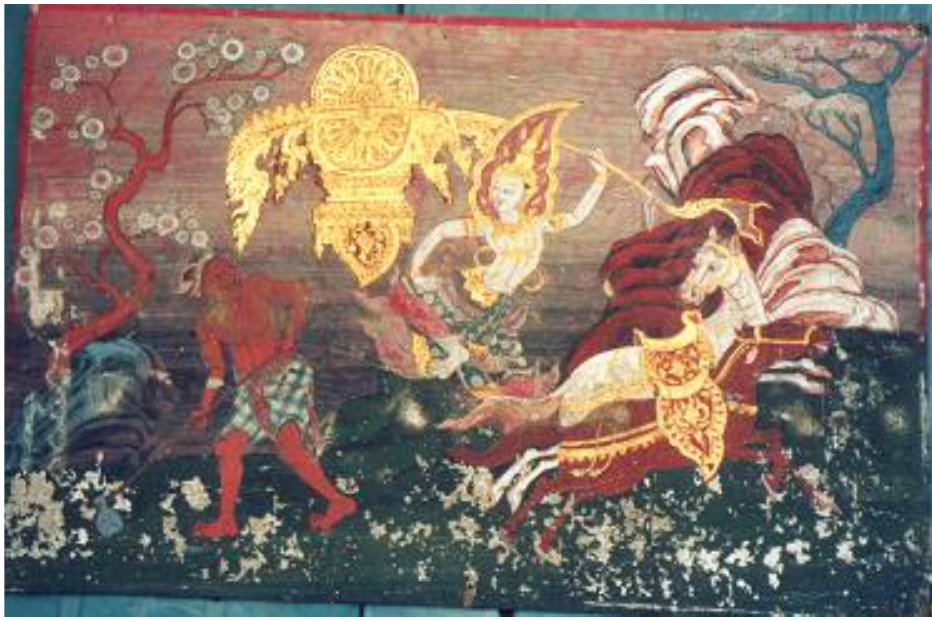
Figure 6. Temiya Jātaka, Thai, mid 20th century, Walters Museum mid 20th century (Rattanakosin) . Figure 6. Temiya J¯ataka, Thai, mid 20th century, Walters Museum mid 20th century (Rattanakosin). MEDIUM; pigments on wood (Painting & Drawing). ACCESSION NUMBER: 2010.12.27. MEDIUM; pigments on wood (Painting & MEASUREMENTSH: 15 3/4 × W: 24 in. (40 × 61 cm).